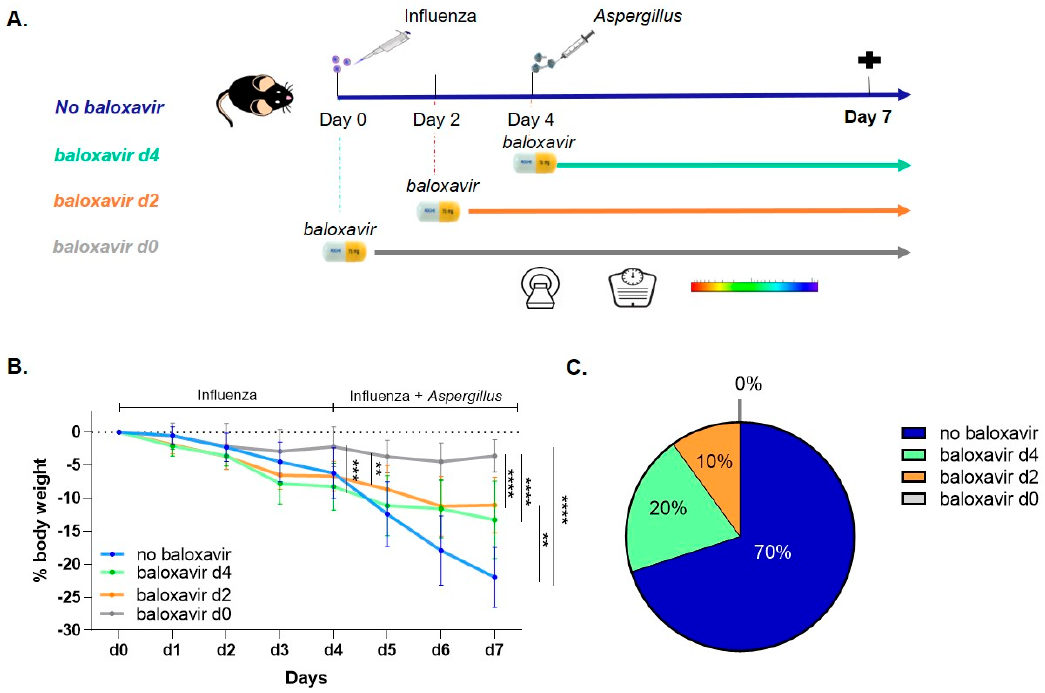
Figure 1. Baloxavir marboxil treatment improves survival and body weight loss. ( A ) Experimental setup: immunocompetent mice received intranasal instillation influenza A followed by orotracheal inoculation with Aspergillus fumigatus 4 days later. Baloxavir marboxil treatment or sham (no baloxavir, blue) was started at day 4 (green), day 2 (orange) or day 0 (grey) up to day 7. Mice were longitudinally monitored for body weight, with micro-computed tomography ( µ CT) and bioluminescence imaging (BLI). ( B ) Relative body weight evolution of influenza/ Aspergillus co-infected mice receiving sham treatment (no baloxavir, blue, n = 10 mice), baloxavir marboxil treatment starting from day 4 (green, n = 10 mice), baloxavir marboxil treatment started on day 2 (orange, n = 10 mice) and baloxavir marboxil treatment from day 0 (grey, n = 10 mice). ( C ) Pie chart representing survival expressed as the percentage (%) of animals reaching humane endpoint (>20% body weight loss) at day 7. Differences were considered significant if p was smaller or equal to 0.05. ** p < 0.01, *** p < 0.001, **** p < 0.0001. Data are represented as mean ±